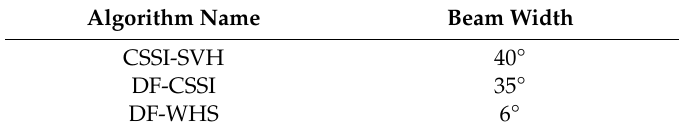
Table 3. Beam widths of the three algorithms in the 100–1500 Hz processing frequency band.